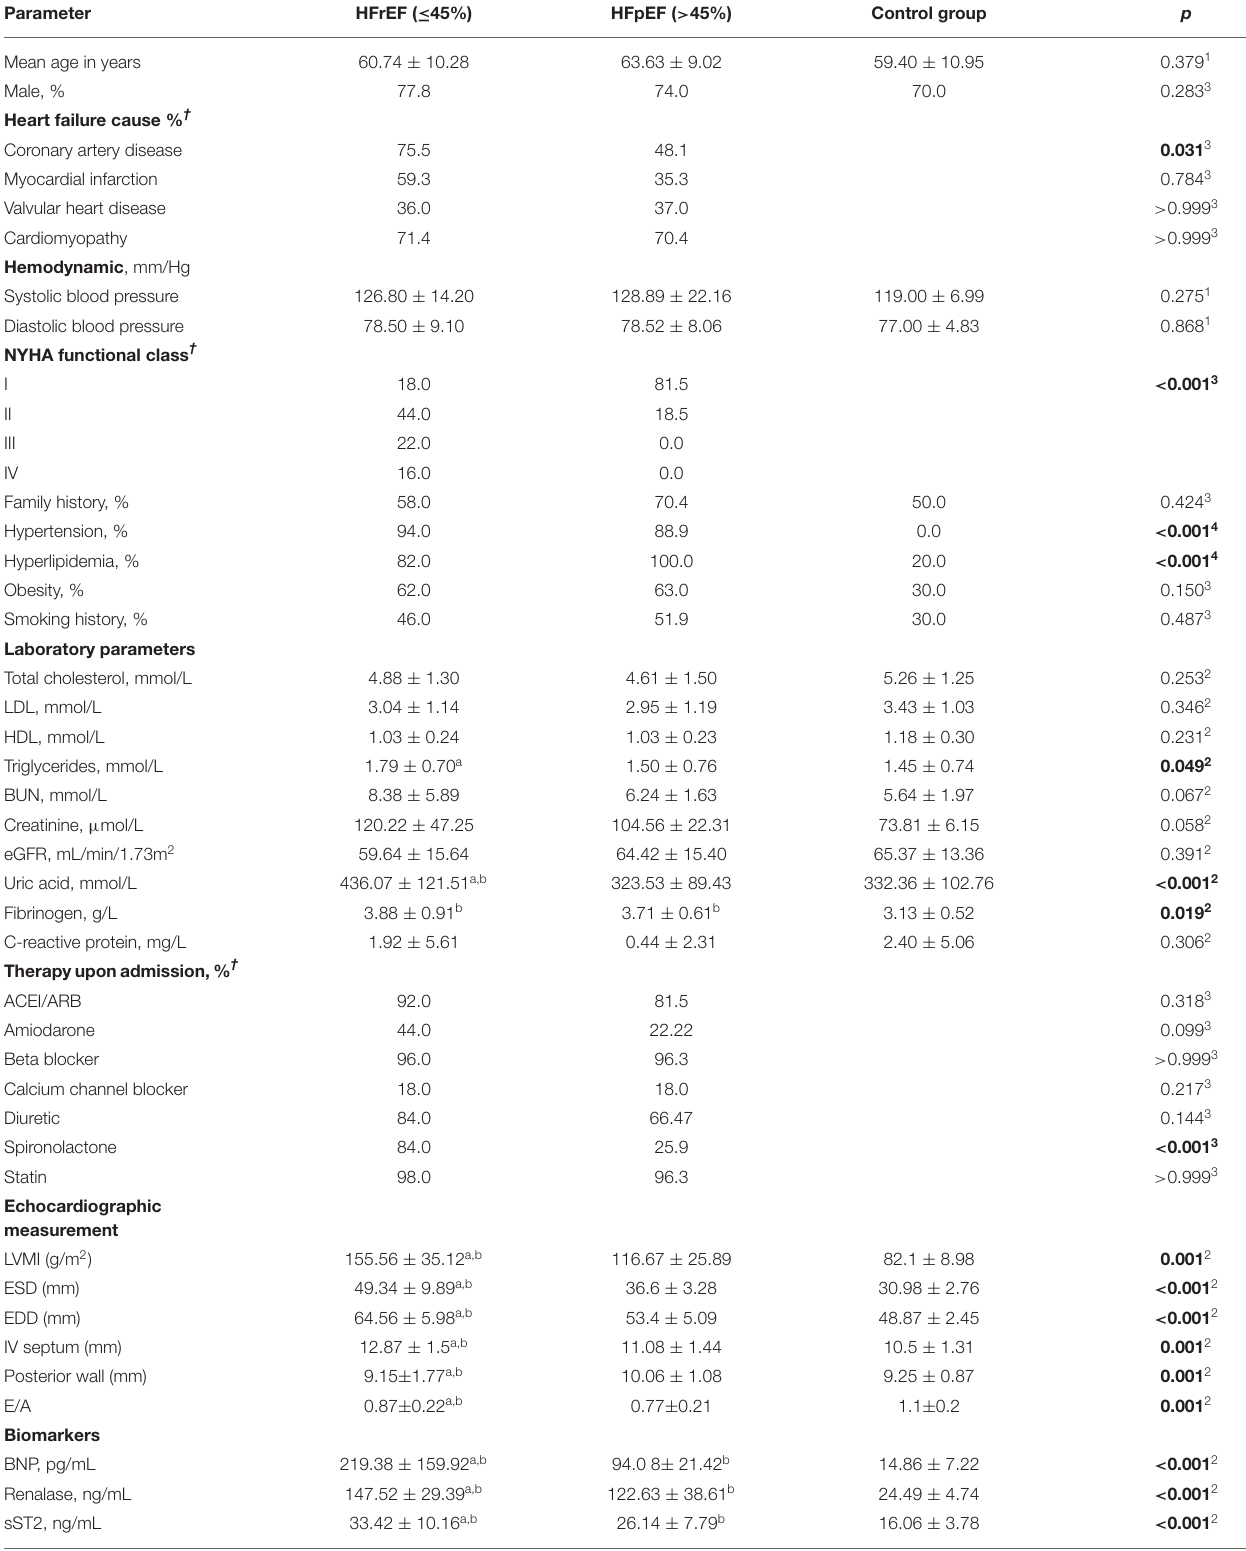
TABLE 1 | Baseline characteristics of study